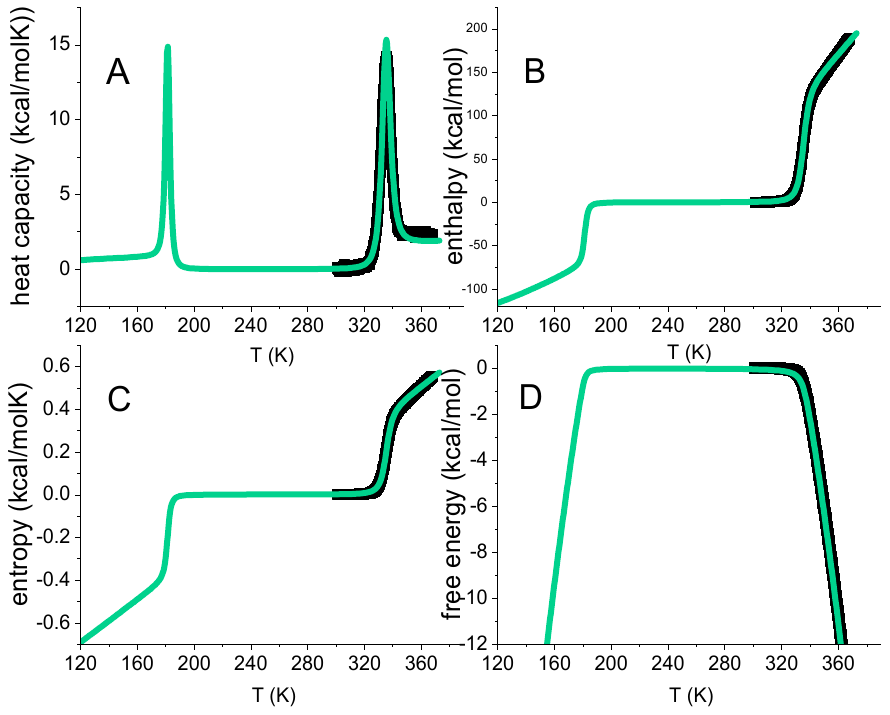
Figure 5. Multistate cooperative model. Green lines calculated with: N = 129 amino acid residues. h 0 = 900 cal/mol. c v = 7 cal/molK. Cooperativity parameter σ = 5 × 10 − 7 . Black data points: thermal unfolding of lysozyme measured with DSC. Same data as in Figure 1.